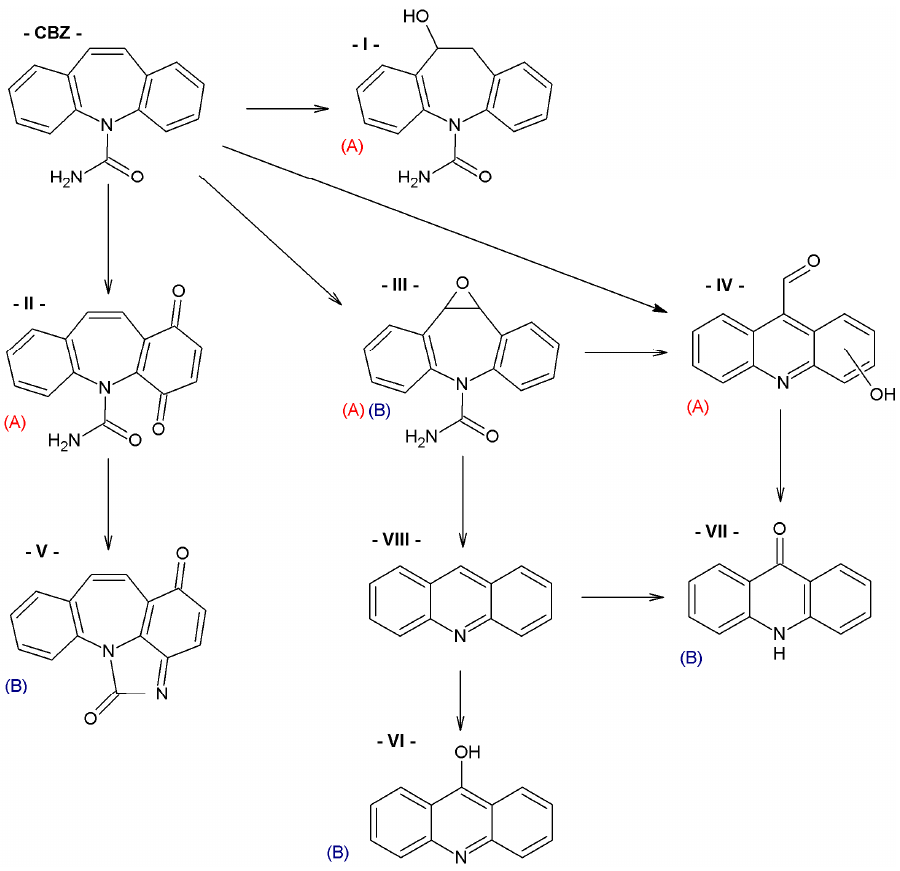
Figure 5. CBZ degradation pathways photo-induced by Fe 3 O 4 / LHA in the absence (A) and presence (B) of H 2 O 2 .